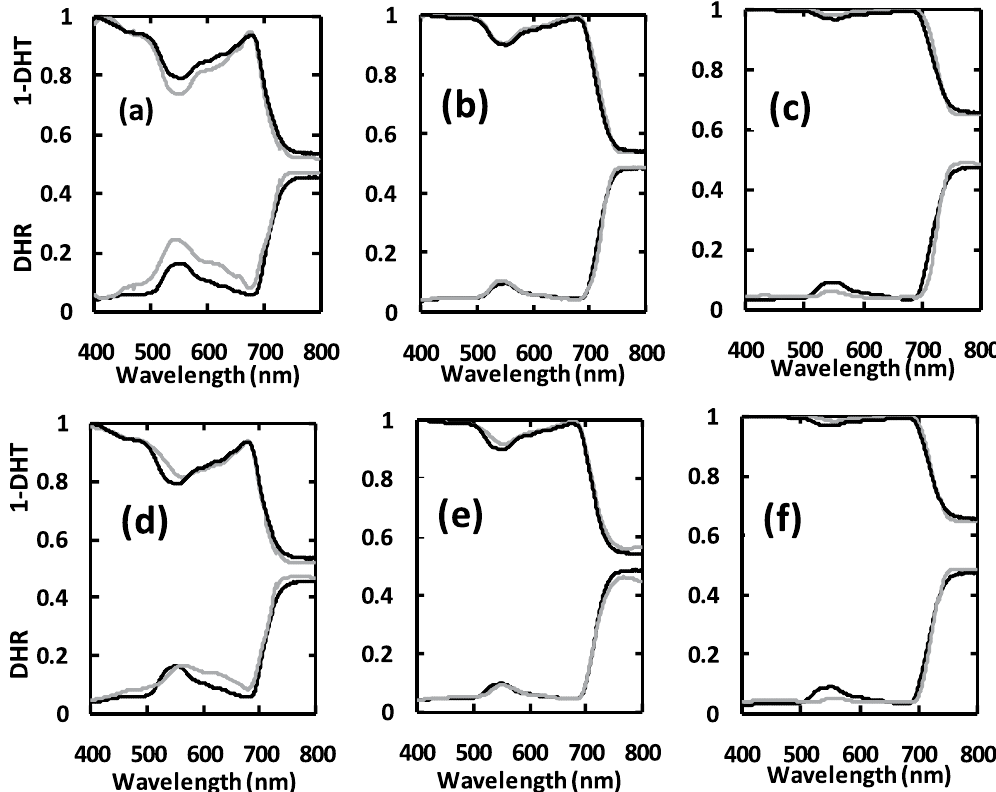
Figure 3. Comparison of measured (black) and simulated (grey) reflectance and transmittance for ( a ) low (Chla = 15.11 μ g/cm 2 ; Chlb = 4.25 μ g/cm 2 ; Cars = 5.94 μ g/cm 2 ), ( b ) medium (Chla = 47.86 μ g/ cm 2 ; Chlb = 13.35 μ g/cm 2 ; Cars = 9.92 μ g/cm 2 ) and ( c ) high (Chla = 90.52 μ g/cm 2 ; Chlb = 29.34 μ g/cm 2 ; Cars = 27.41 μ g/cm 2 ) pigment concentration levels from P5; and ( d ) low, ( e ) medium and ( f ) high levels from